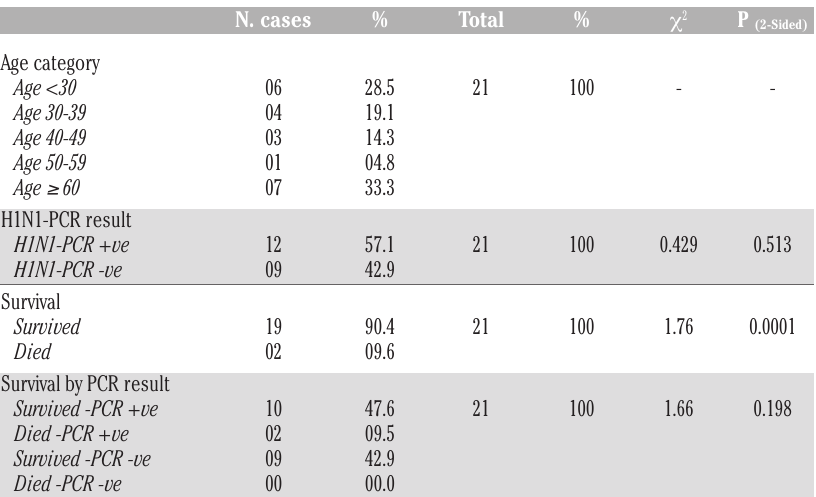
Table 4. Distribution of outbreak patients by main study variables